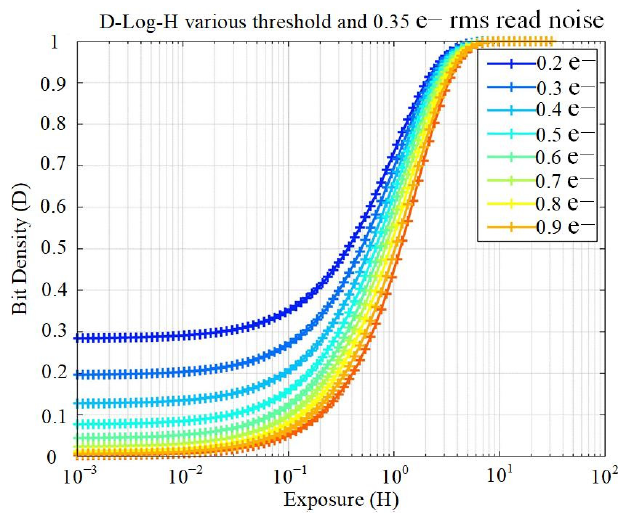
Figure 11. Theoretical bit density vs. exposure for different thresholds (input-electron referred) with 0.35 e − rms read noise [15].